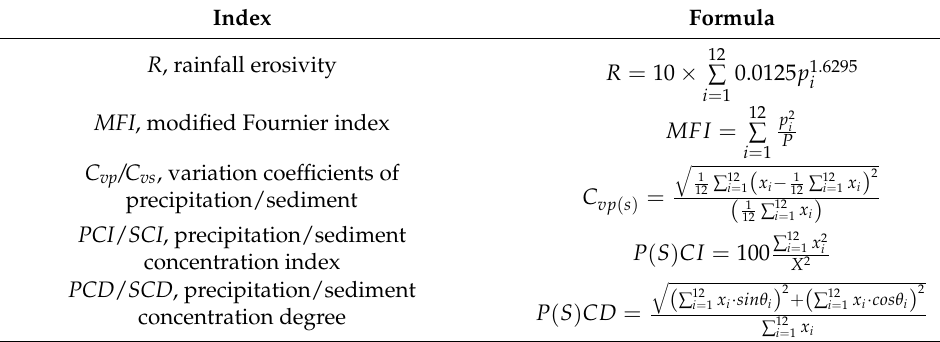
Table 1. The formula of rainfall and sediment discharge